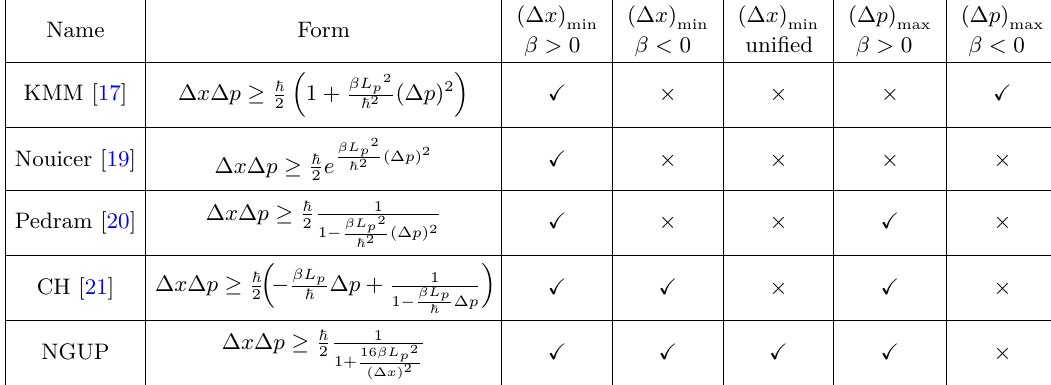
unified” means that min